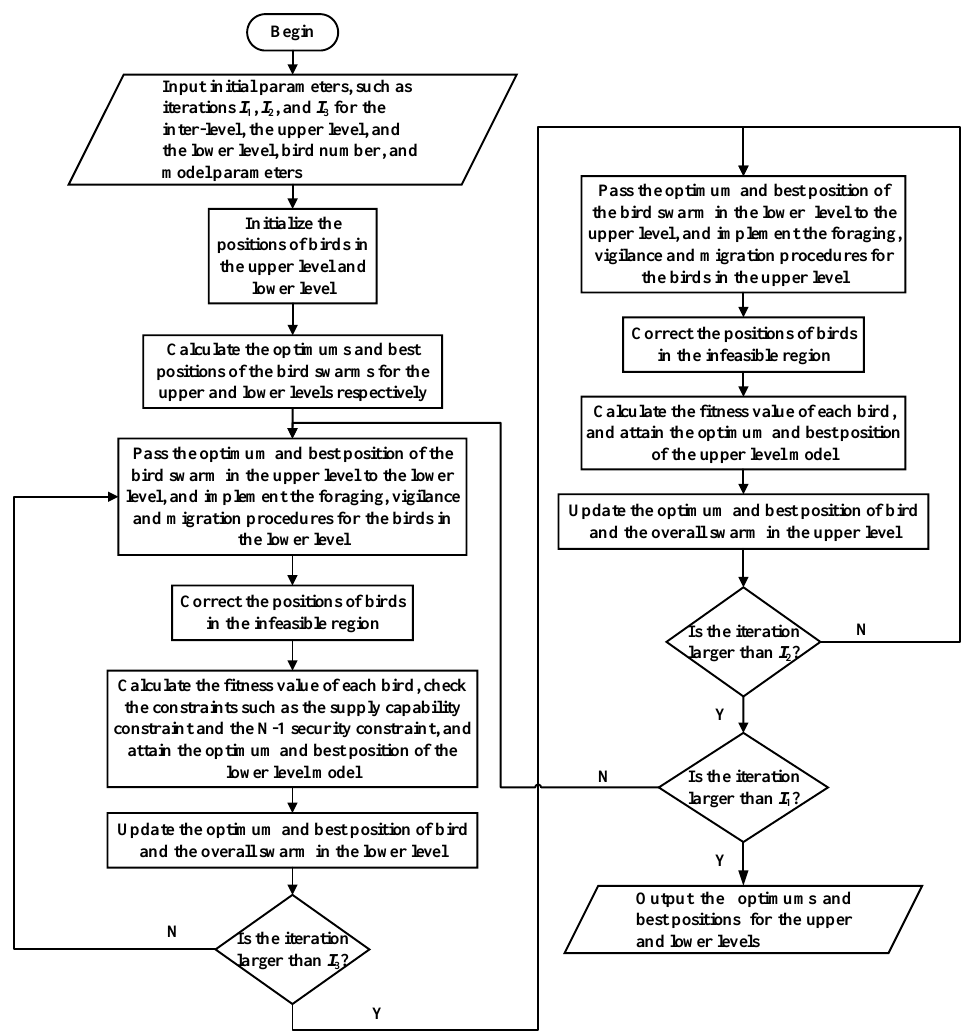
Figure 2. The bird swarm algorithm (BSA)-based optimization procedures for joint planning of substations and lines in distribution systems.